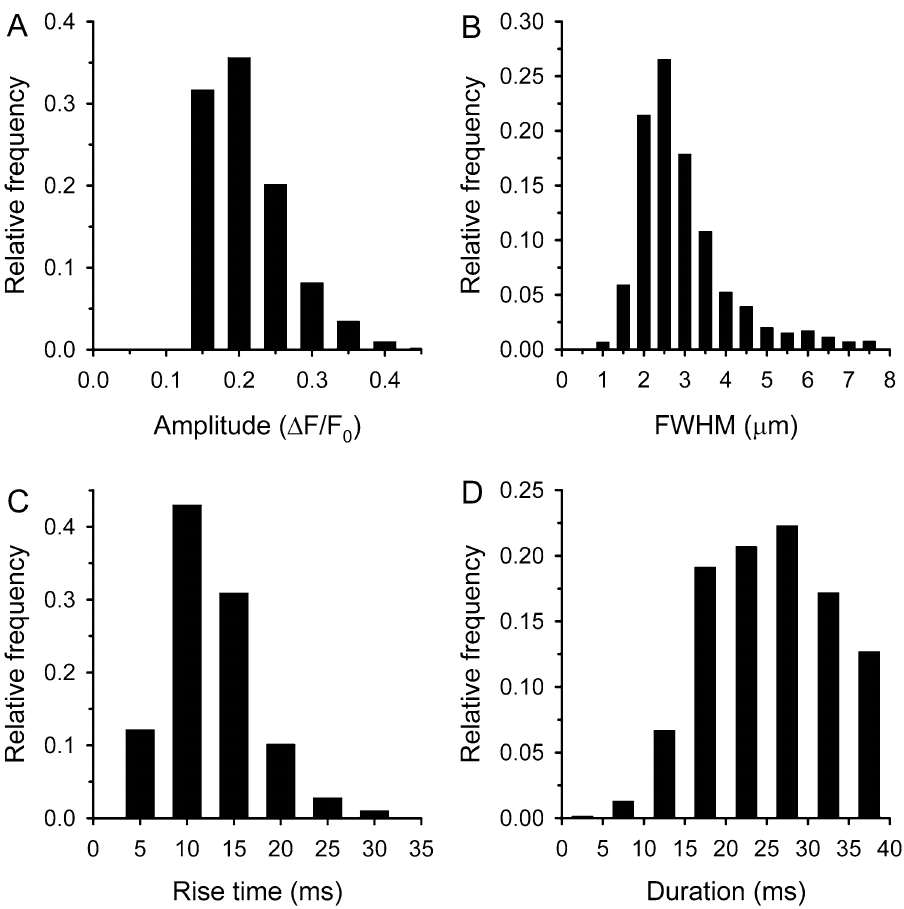
Figure 5. Parameters of calcium sparks. Histogram of amplitudes ( A ), FWHMs ( B ), rise times ( C ), and durations ( D ). The number of sparks was